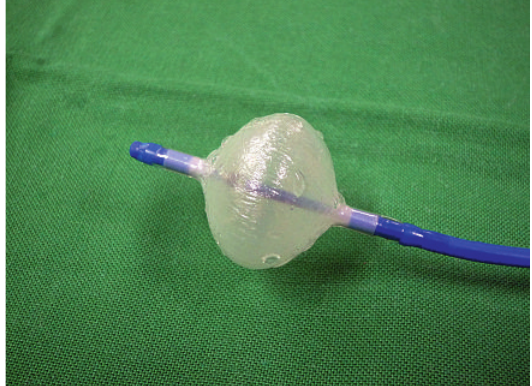
Fluoroscopic image in a left anterior oblique view (43 degrees) showing complete occlusion of the right superior PV (demon- strated by injection of contrast) using a 28 mm cryoballoon catheter (black arrows).The guidewire is advanced into a superior branch of the right superior PV.The quadripolar catheter in the superior vena cava (white arrow) for stimulation of the phrenic nerve is also